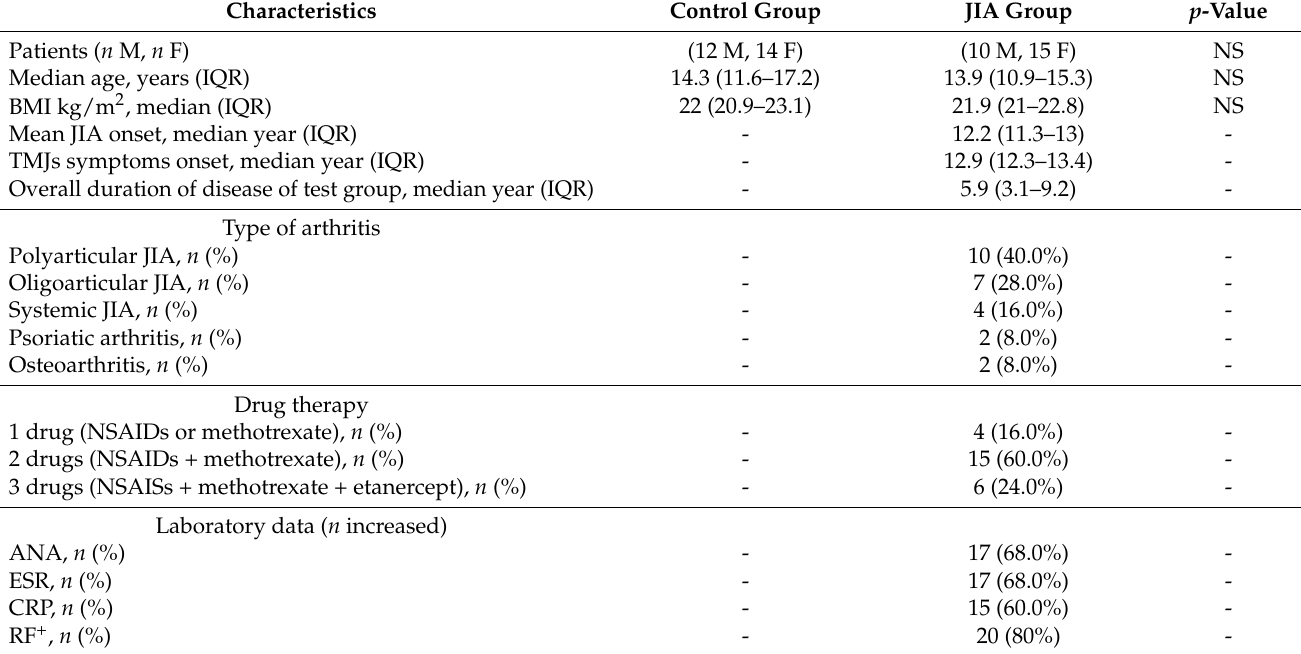
Table 1. Demographic and clinical characteristics in the two